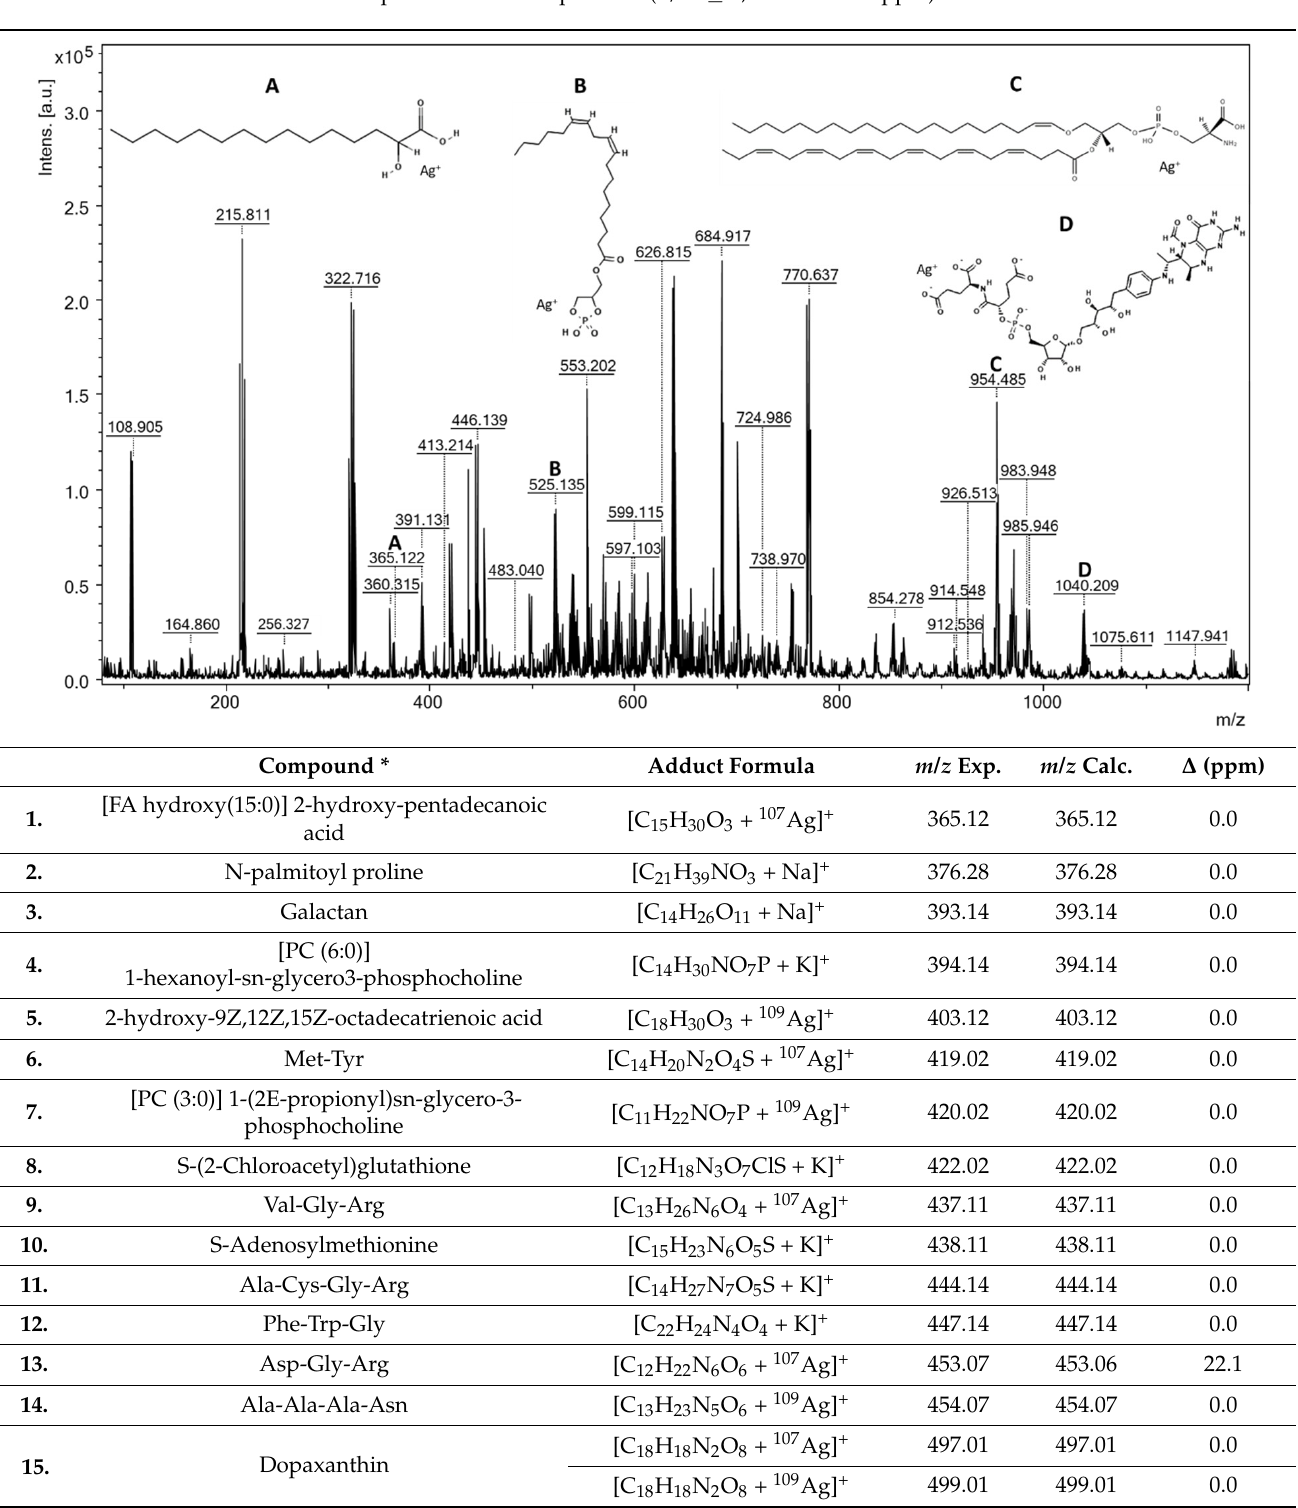
Table 5. SALDI mass spectrum of Weissella cibaria lipid extract made on an AgNLET plate with